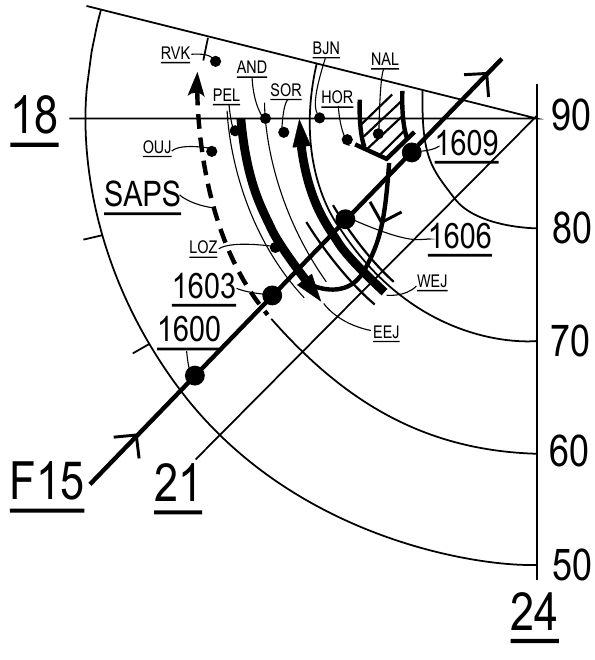
Fig. 6. Overview of ground-satellite F15 conjunction in the 18:00– 21:00MLT sector during the interval 16:00–16:10UT. The coordi- nate system is MLT versus MLAT. The three latitudinal regimes of (i) SAPS (westward ion drift ( V w ) > 0.5kms − 1 centered at ∼ 60 ◦ MLAT), (ii) plasma sheet precipitation and the eastward elec- trojet (EEJ) current within 64–66 ◦ MLAT, and (iii) arcs near the poleward boundary accompanied by westward electrojet (WEJ) current within 68–71 ◦ MLAT have been marked along the track and in the MLT sector of the magnetometer stations. The loca- tions of nine ground magnetometer stations in the IMAGE network (mainly along the 18:00MLT meridian) are marked by solid dots. Solid curved lines mark the centers of the westward (WEJ) and eastward (EEJ) electrojet activities as estimated from the ground magnetograms and the satellite observations of cross-track ion drift/precipitation. The center of the westward-directed ion drift at subauroral latitudes (SAPS), as inferred from the satellite ion drift data, is marked by the westward-directed dashed curved arrow. Po- lar cap flow channel FC 3 (enhanced antisunward convection) above Svalbard detected by SuperDARN at 15:56UT is marked by the wide, hatched arrow in the Svalbard